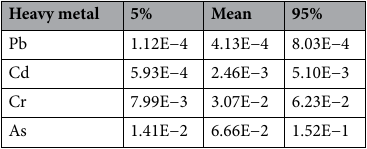
Table 15. Summary of the Monte Carlo